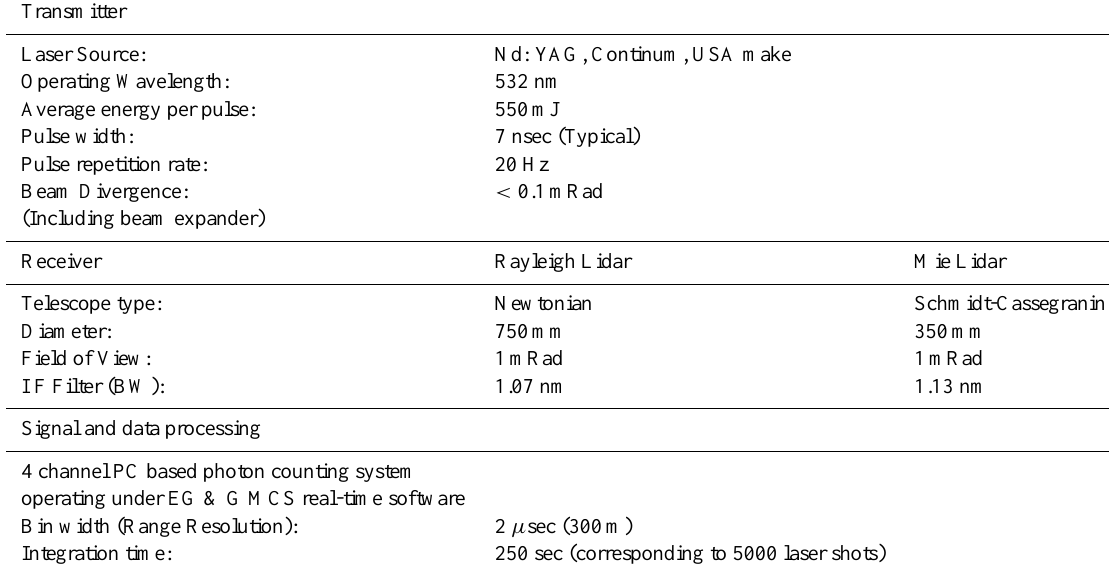
Table 2. Major specifications of the Indo-Japanese lidar